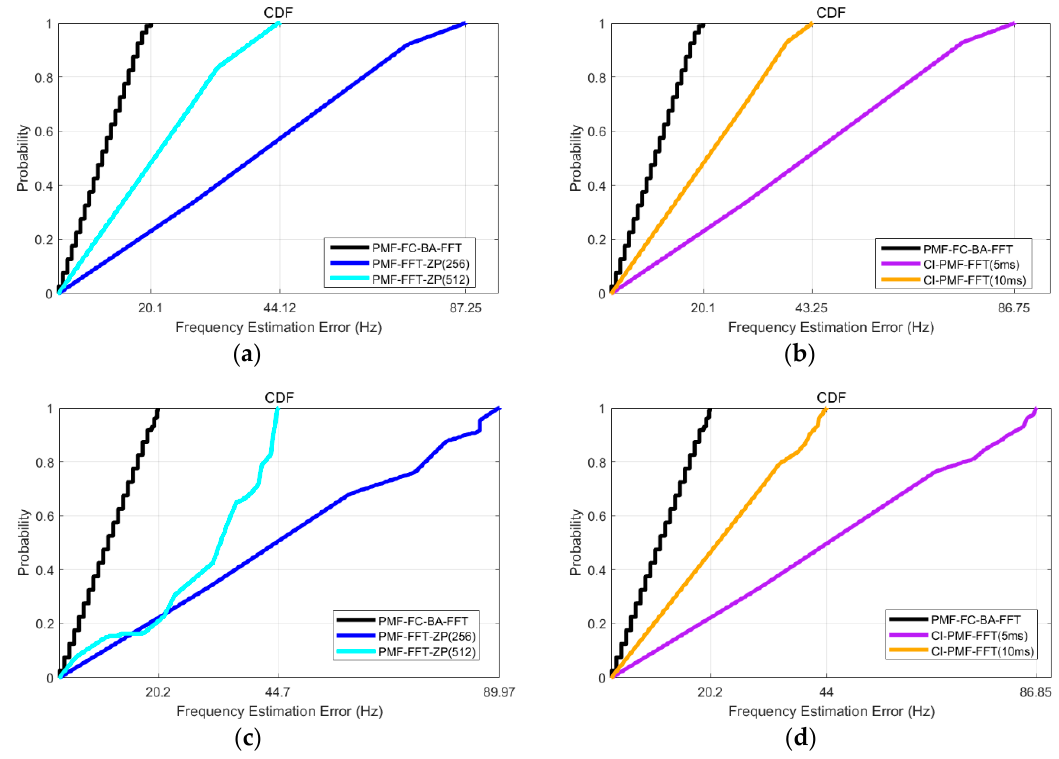
Figure 10. ( a ) CDF of PMF-FC-BA-FFT and PMF-FFT-ZP when SNR was − 20 dB; ( b ) CDF of PMF-FC-BA-FFT and CI-PMF-FFT when SNR was − 20 dB; ( c ) CDF of PMF-FC-BA-FFT and PMF-FFT-ZP when SNR was − 26 dB; ( d ) CDF of PMF-FC-BA-FFT and CI-PMF-FFT when SNR was − 26 dB.